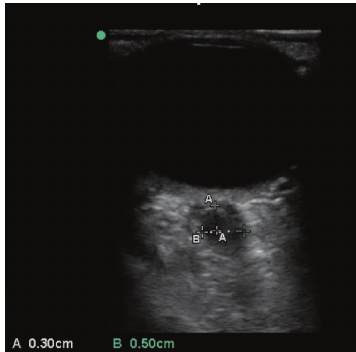
Figure 2: Bedside ocular ultrasound of the patient’s left eye demonstrating optic nerve sheath diameter (ONSD) measurement. The measurement of the ONSD is taken 3 mm posterior to the globe and occurs perpendicular to the long axis of the optic nerve.